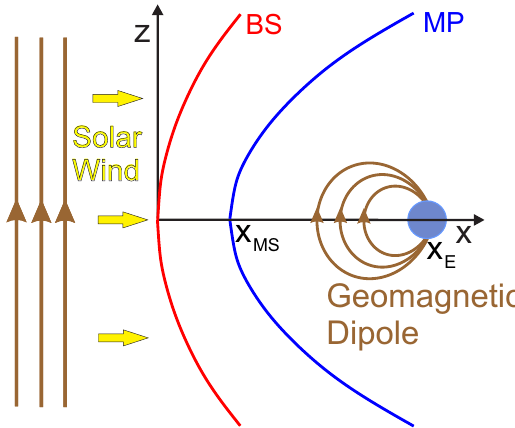
Fig. 3. The incident solar wind in x-direction with its field along the z-direction on the left side and the Earth with its dipole field on the right side. The origin of the Cartesian coordinate system ( x,y,z ) shall be at the nose of the bow shock